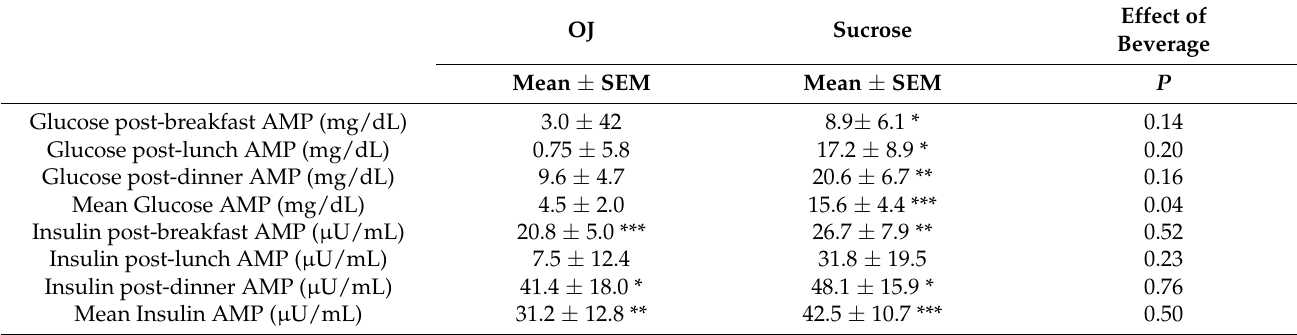
Figure 6. The 16-hour circulating glucose and insulin concentrations before (black line) and after (blue line) consumption of either ( A , C ) OJ or ( B , D ) sucrose-SB beverage for two weeks. Plasma was collected during consumption of energy-balanced meals at breakfast, lunch and dinner containing 55% Ereq as complex carbohydrate at baseline and during consumption of energy-balanced baseline diets containing 30% Ereq as complex carbohydrate and 25% as OJ or sucrose-SB at 2 weeks. Table 4. Changes in glucose and insulin amplitudes after two weeks of OJ or sucrose-SB intake. OJ